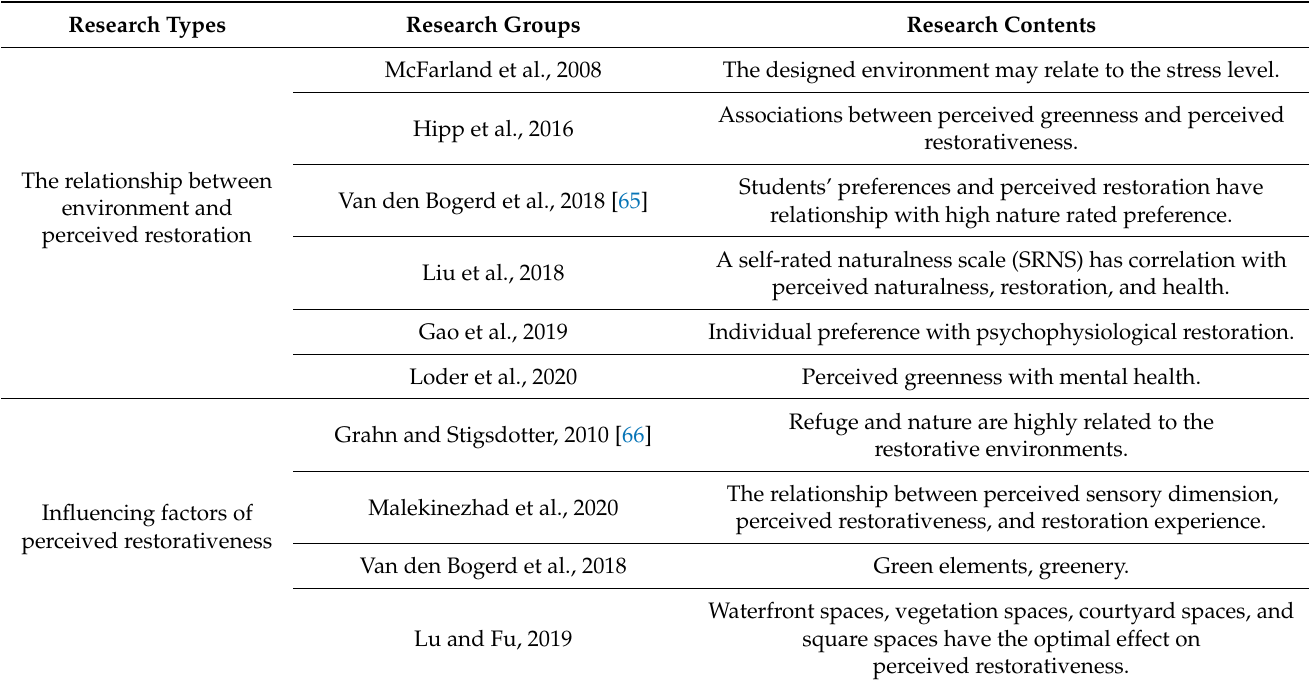
Table 3. Research on health and restorativeness on campus